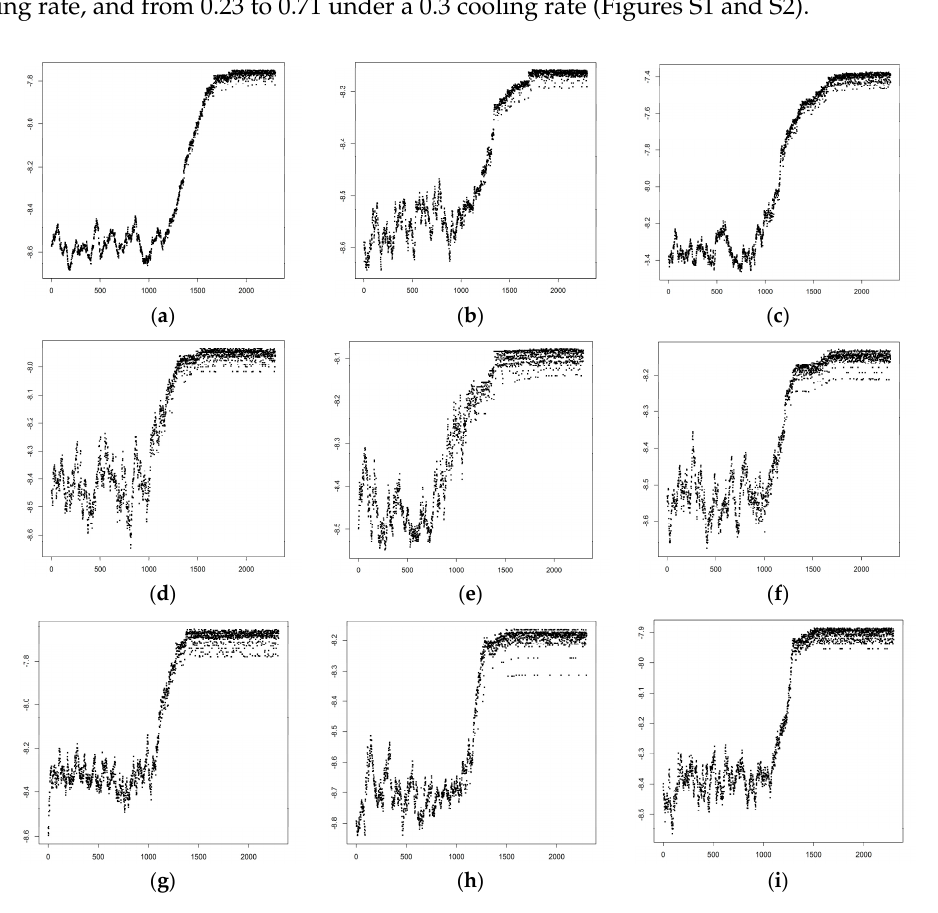
Figure 2. Objective function values or geometric mean of likelihood of all included samples, demonstrated (Y axis) versus the iterations (X axis) under a 0.5 cooling rate for: ( a ) Asota egens indica ; ( b ) Asota heliconia zebrine ; ( c ) Biston perclarus ; ( d ) Chrysaeglia magnifica ; ( e ) Histia flabellicornis ultima ; ( f ) Hyposidra talaca ; ( g ) Lebeda nobilis ; ( h ) Spodoptera litura ; and ( i ) Traminda aventiaria . Table 1. The number of observations in GBIF, FB, FB_o, as well as the proportion of the number of observations in FB_o to the number of observations in FB.